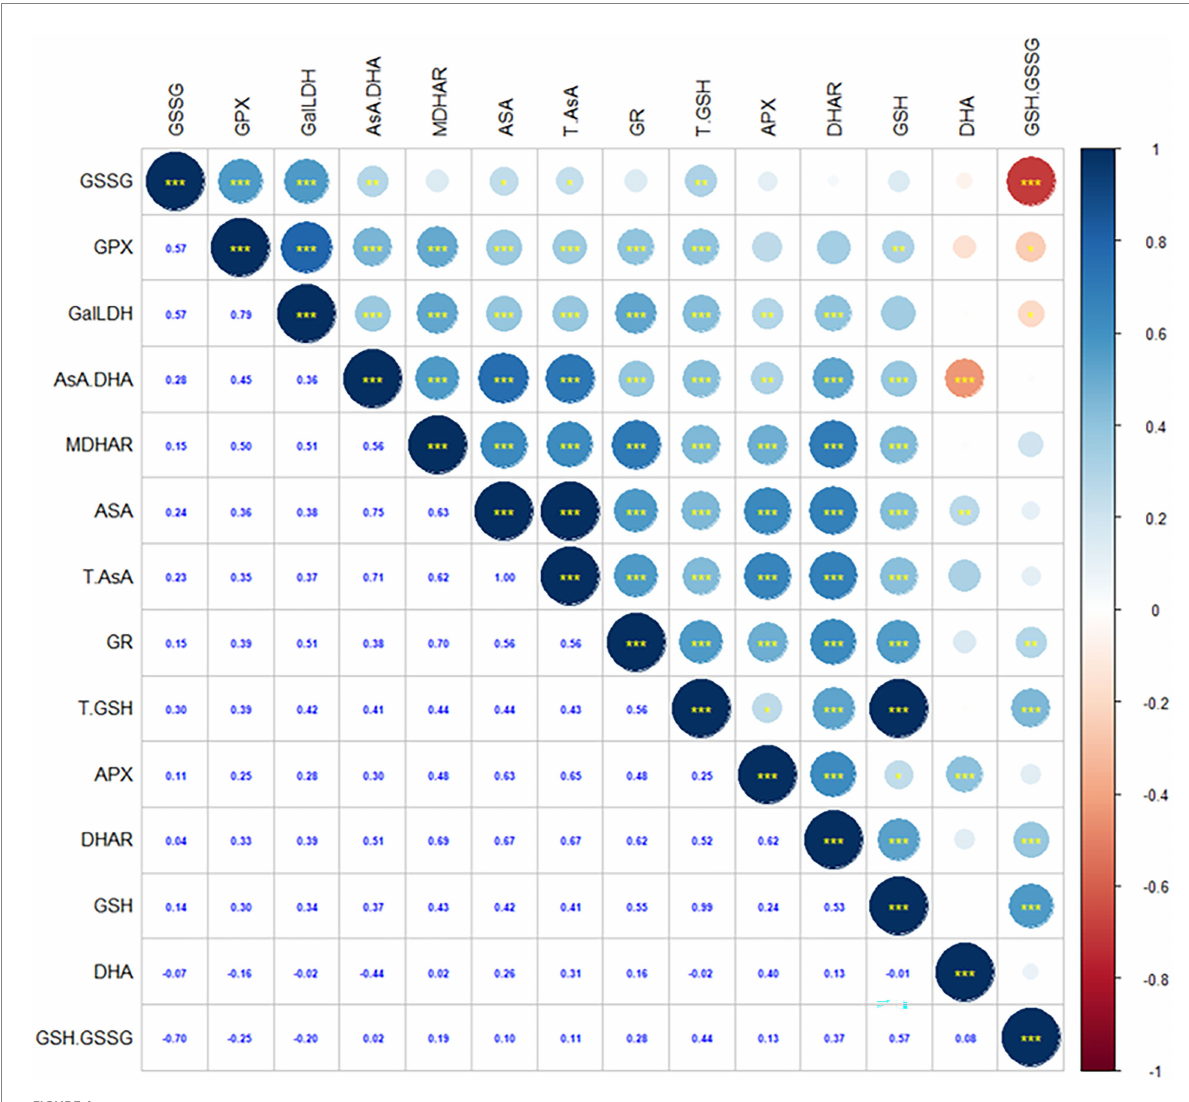
FIGURE 4 The Spearman’s correlation coefficient between non-enzymatic substance accumlation and enzyme activities in AsA-GSH cycle of hairgrass ( Deschampsia caespitosa ) under different hydrological regimes. AsA---ascorbate, DHA---dehydroascorbate, T-AsA, the sum of ascorbate and dehydroascorbate; AsA/DHA, the ratio of ascorbate to dehydroascorbate; GSH, reduced glutathione; GSSG, oxidized glutathione; T-GSH, the sum of reduced glutathione and oxidized glutathione; GSH/GSSG, the ratio of reduced glutathione to oxidized glutathione; APX, ascorbate peroxidase; DHAR, dehydroascorbate reductase; GPX, glutathione peroxidase; GR, glutathione reductase; GalLDH, L-galactono-1; 4-lactone dehydrogenase; MDHAR, monodehydroascorbate